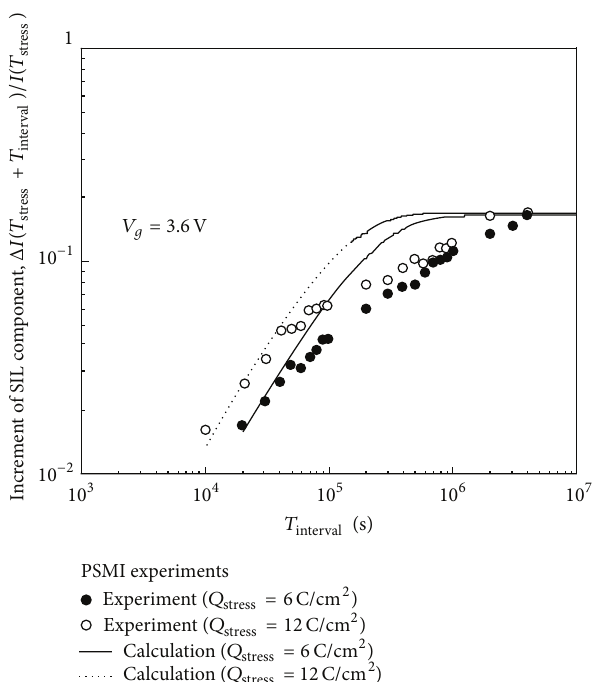
+ 𝑇 )/ Figure 5: Time evolution of gate current (Δ𝐼(𝑇 stress interval (𝑇 )) after a single stress application. The CCS condition 𝐼 stress stress is 500 mA/cm 2 in all experiments. 𝑄 stress is 6 C/cm 2 or 12C/cm 2 . Symbols are measured results, and lines are the results calculated using (8). The characteristic time constant ( 𝜏 2 ) is 3.0 × 10 6 sec for = 6 C/cm 2 and 1.5 × 10 6 sec for 𝑄 𝑄 stress